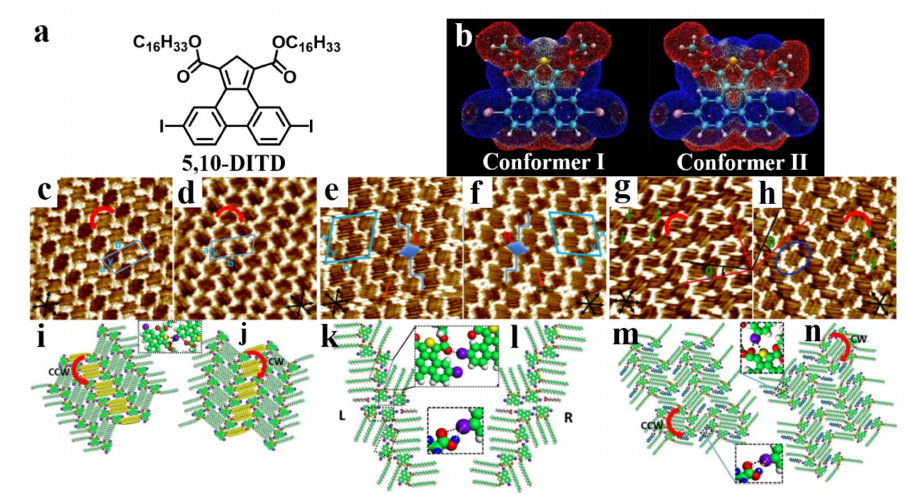
Figure 16. ( a ) Chemical structure of 5,10-BITD. ( b ) Calculated 3D charge density maps of 5,10-DITD with di ff erent configurations of ester groups. ( c – h ) High-resolution STM images of CCW and CW honeycomb-like, kite-like, and cyclic networks formed by 5,10-DITD at the 1-octanic acid / HOPG interface (2.0 × 10 − 3 M; 5.0 × 10 − 4 M; 5.0 × 10 − 5 M; scanning area: 20 × 20 nm 2 ). ( i – n ) Proposed molecular models of ( c – h ) showing R and L kite-like, kite-like, and cyclic networks. Reproduced from [91] with permission from Elsevier B.V.